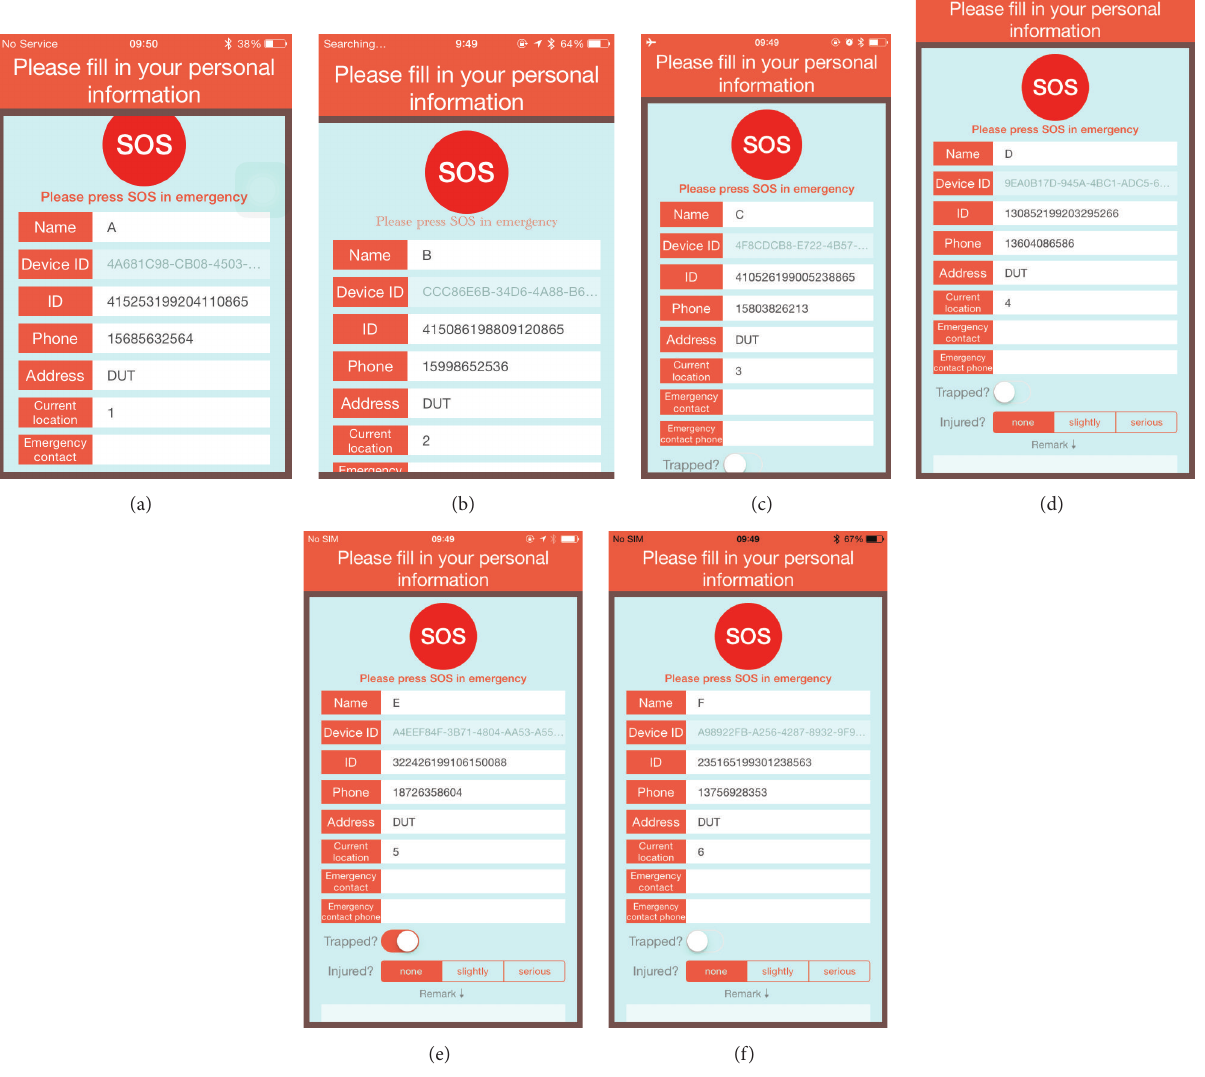
(A) Moving Node Pattern. Figure 8 shows the experiment diagram. A, B, D, E, and F all opened up E-Explorer, and